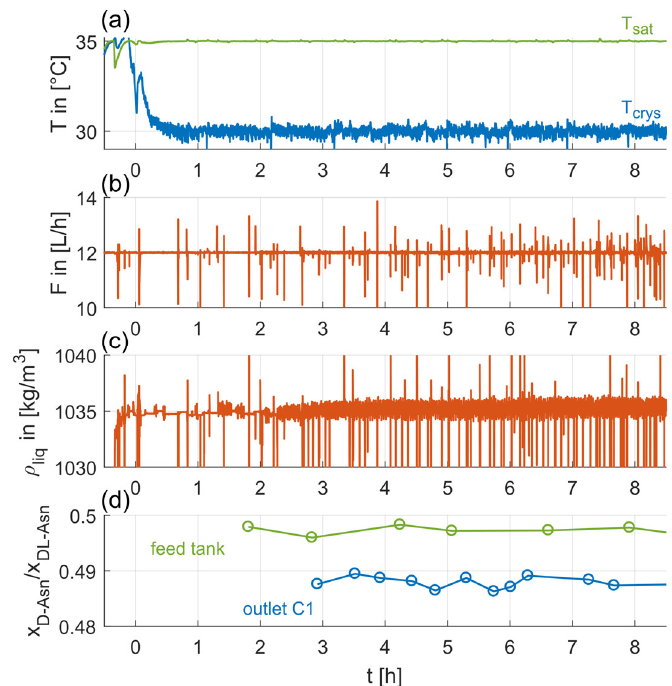
Figure 5. Evolution of the saturation temperature, T sat , crystallization temperature, T crys ( a ), volumetric flowrate ( b ), liquid phase density of the feed solution, ρ liq ( c ), and enantiomeric proportion of the D-Asn · H 2 O in the liquid phase at the crystallizer outlet and within the feed tank ( d ), of Exp. 7 (C1) over time, with t = 0 indicating the initial seeding point. Spikes occurring in the flowrate and solution density courses can be attributed to air bubbles passing the Coriolis mass flowmeter (data shown are raw data without any curve treatment).